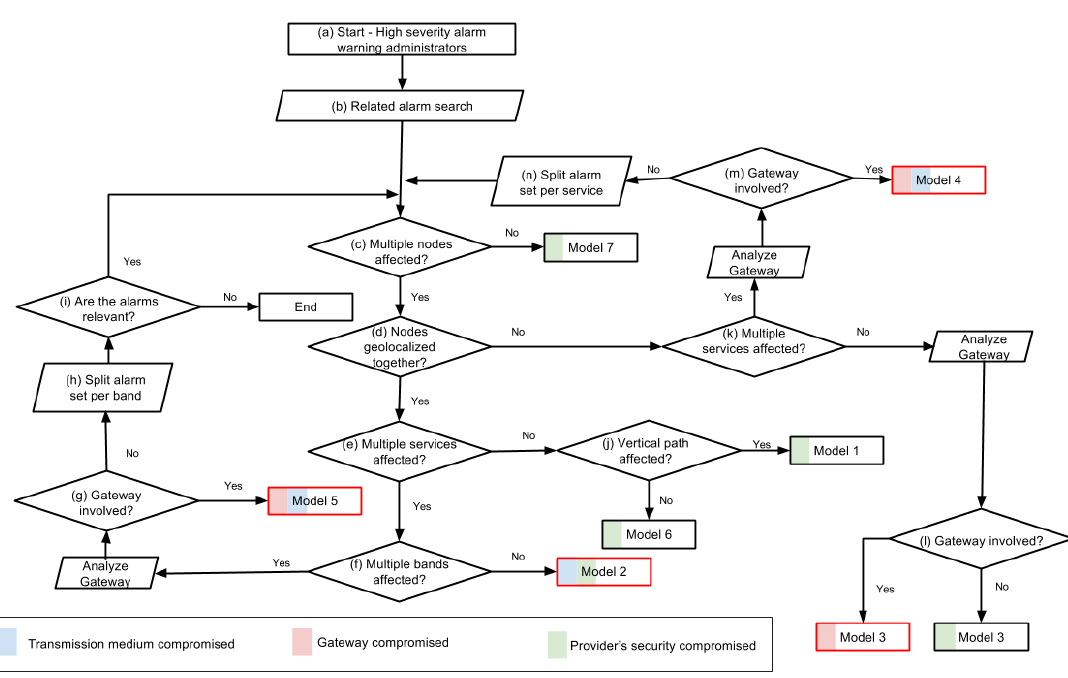
Figure 5. Procedure to classify attacks into seven attack models according to the evidence in the alarms triggered by the detection